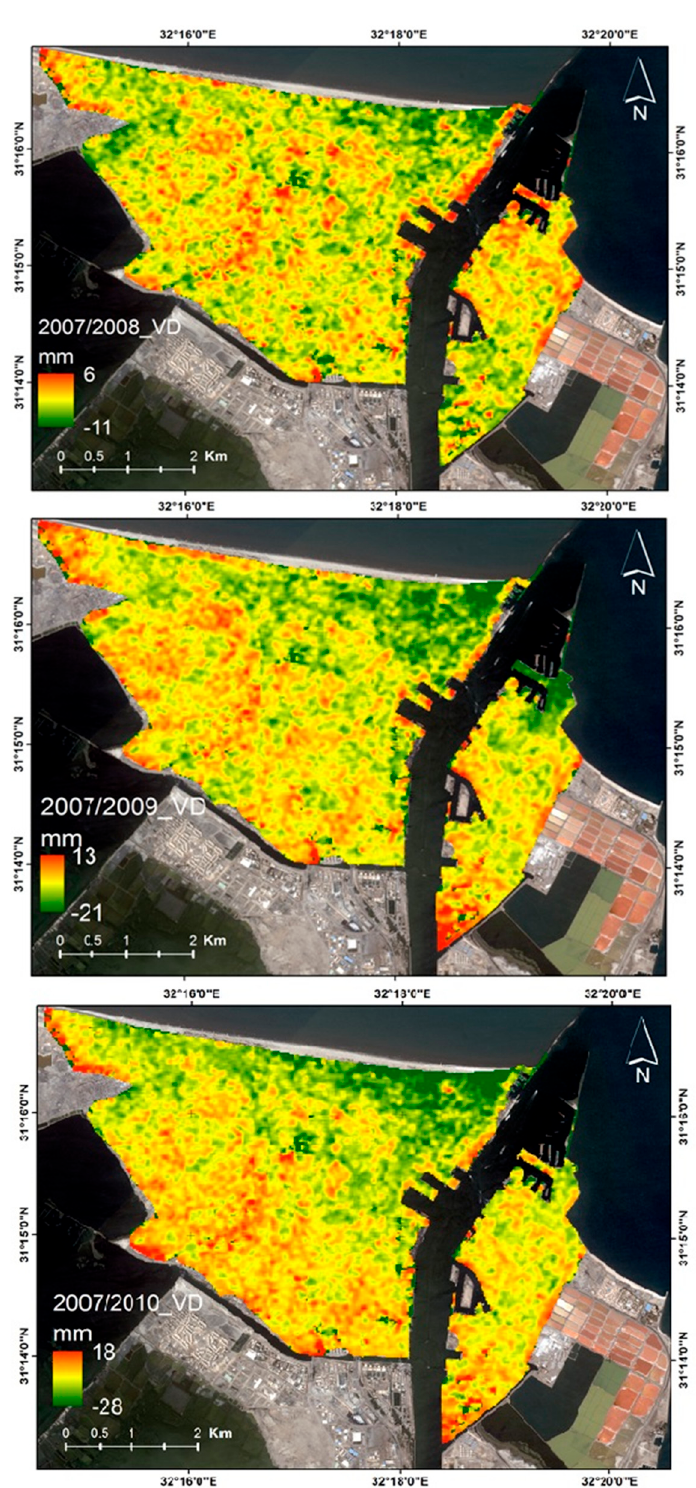
Figure 14. Vertical displacement in Port-Said City from: 2007/2008 ( top ); 2007/2009 ( middle ); and 2007/2010 ( bottom ). The sequence shows that the subsidence rate along the different years is not constant.